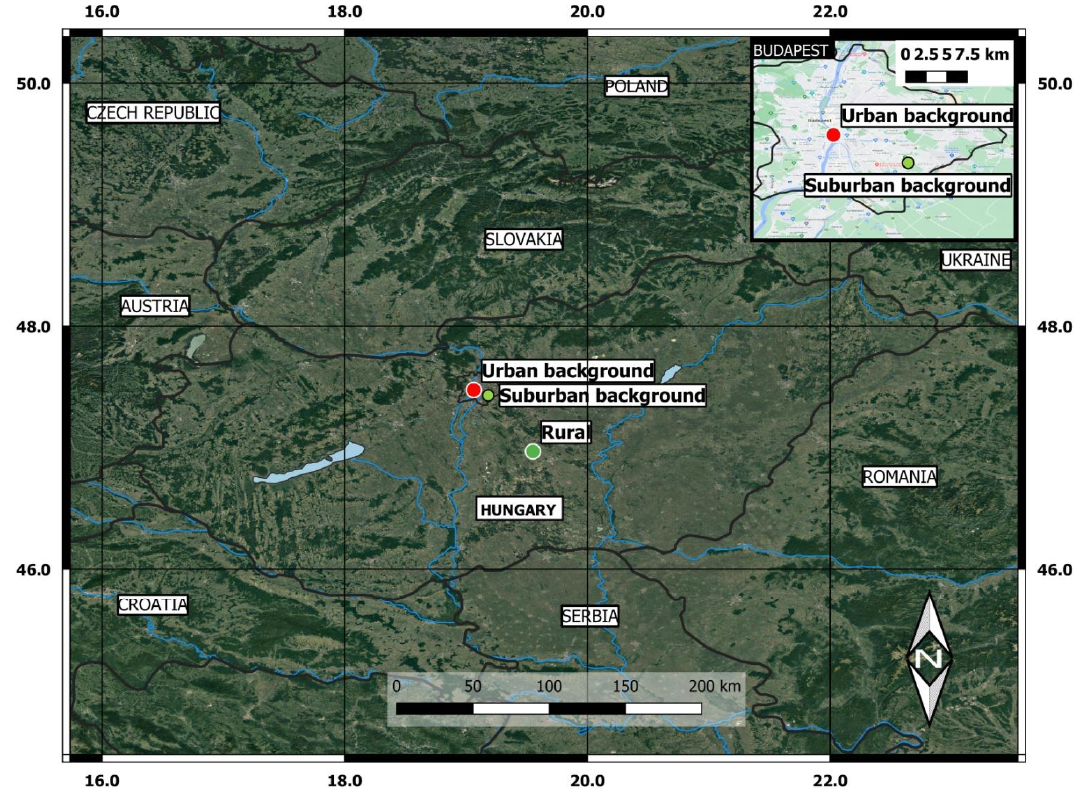
Figure 1. Map of the sampling locations. The text in black boxes shows the location of the sampling points. (Rural site at K-puszta station (dark green); suburban background site, Gilice tér (light green) and urban background site at BpART Lab (red).